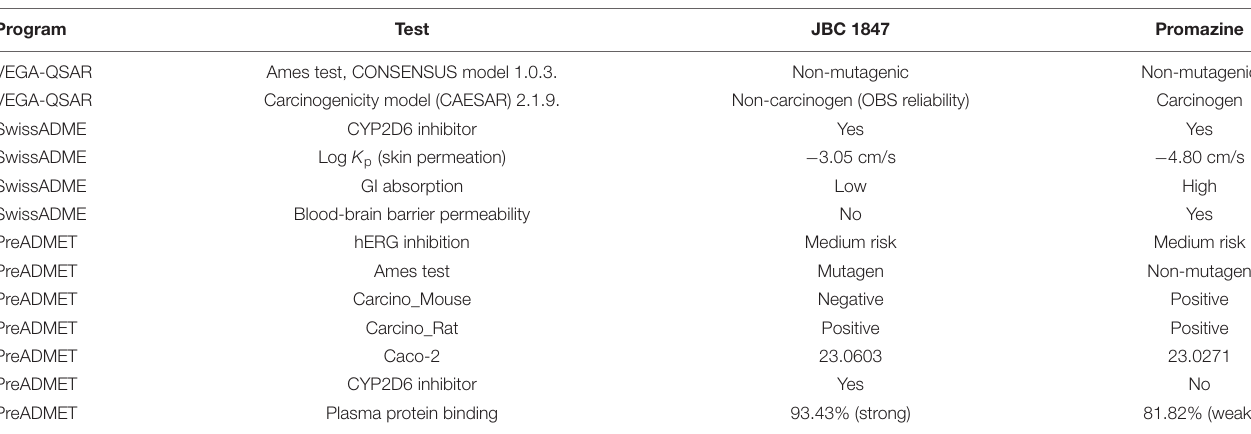
FIGURE 4 | Efficacy of JBC 1847 against Staphylococcus aureus in vivo . The box plot shows bacterial counts [log10(CFU/ml)] from a 4-day wound infection experiment. The sample median is shown within the boxes and the first and third quartile is shown as the upper and lower edge of the boxes, respectively. At day 4 (D4), the bacterial counts were significantly decreased ( P < 0.0001) when wounds were treated with 1 and 2% JBC 1847 (1847), compared with the vehicle treatment. Treatment with 2% Fusidin (fusidic acid) did also result in a significant reduction ( P < 0.05) in bacterial counts. SOT (D1) is the start of treatment on day 1 (D1). TABLE 5 | Pharmacological predictions in